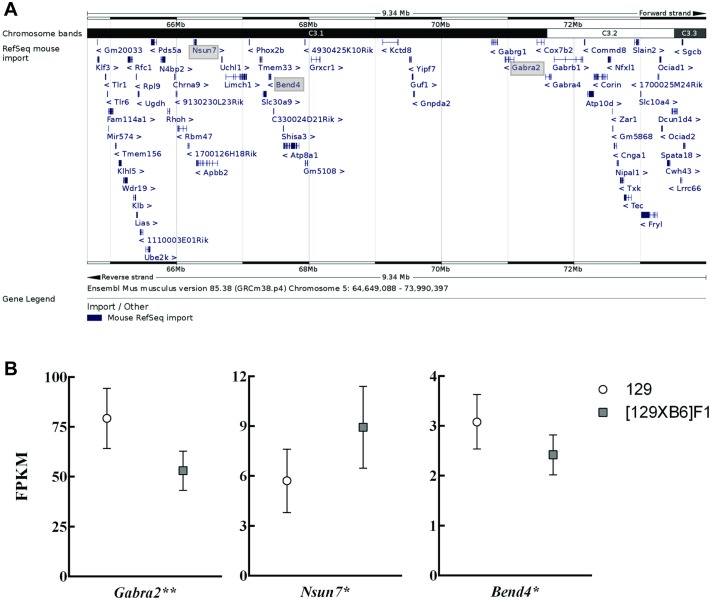
Evaluation of Dsm1 Candidate Genes by RNA-Seq.A. The refined map interval is shown with mouse RefSeq gene annotations. The genes with strain-dependent differential expression are indicated by grey shading (Ensembl Mouse GRCm38.p4)[53]. B. Three genes within the Dsm1 interval showed significant differences in brain expression between wildtype 129 and [129xB6]F1 mice: Gabra2 (q < 0.0029**), Nsun7 (q < 0.02*), and Bend4 (q< 0.02*). Shown are RNA-Seq FPKM values and 95% confidence intervals calculated by String Tie. q-values are false discovery rate-adjusted p-values.